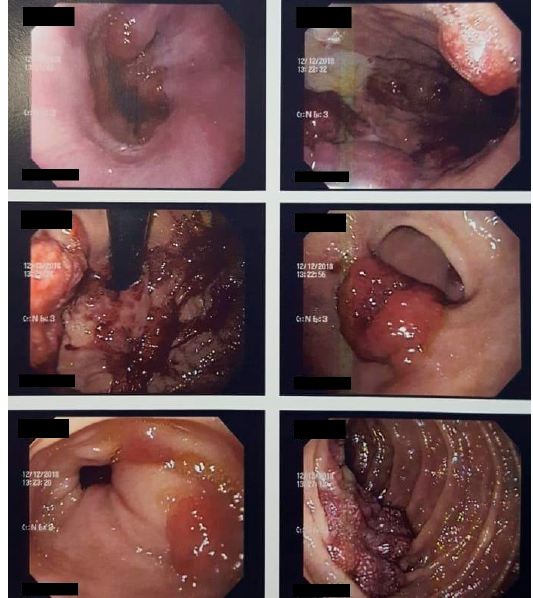
Figure 3. Upper digestive endoscopy identified the presence of diffuse violet lesions of nodular